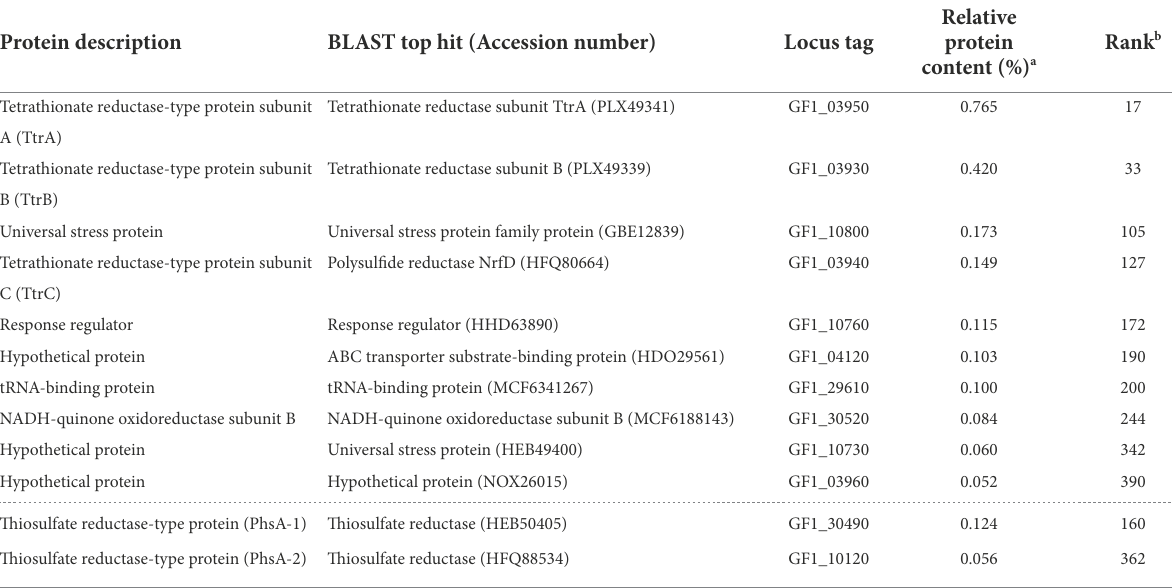
TABLE 2 Top 10 abundant proteins only detected in TD.